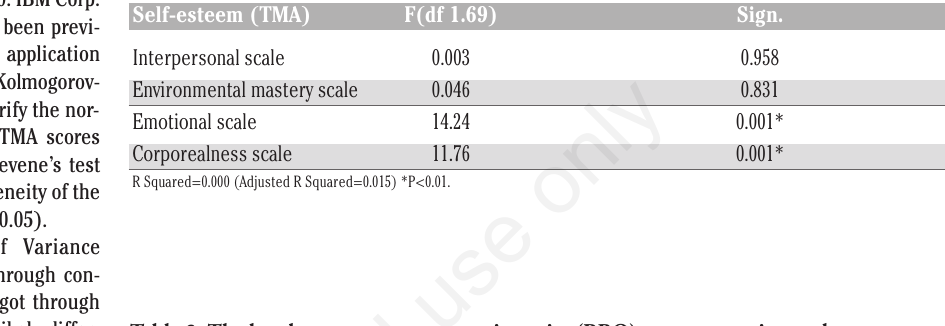
Table 3. The brother as a resource questionnaire (BRQ) scores: experimental group scores (N=40) and expected mean scores. BRQ